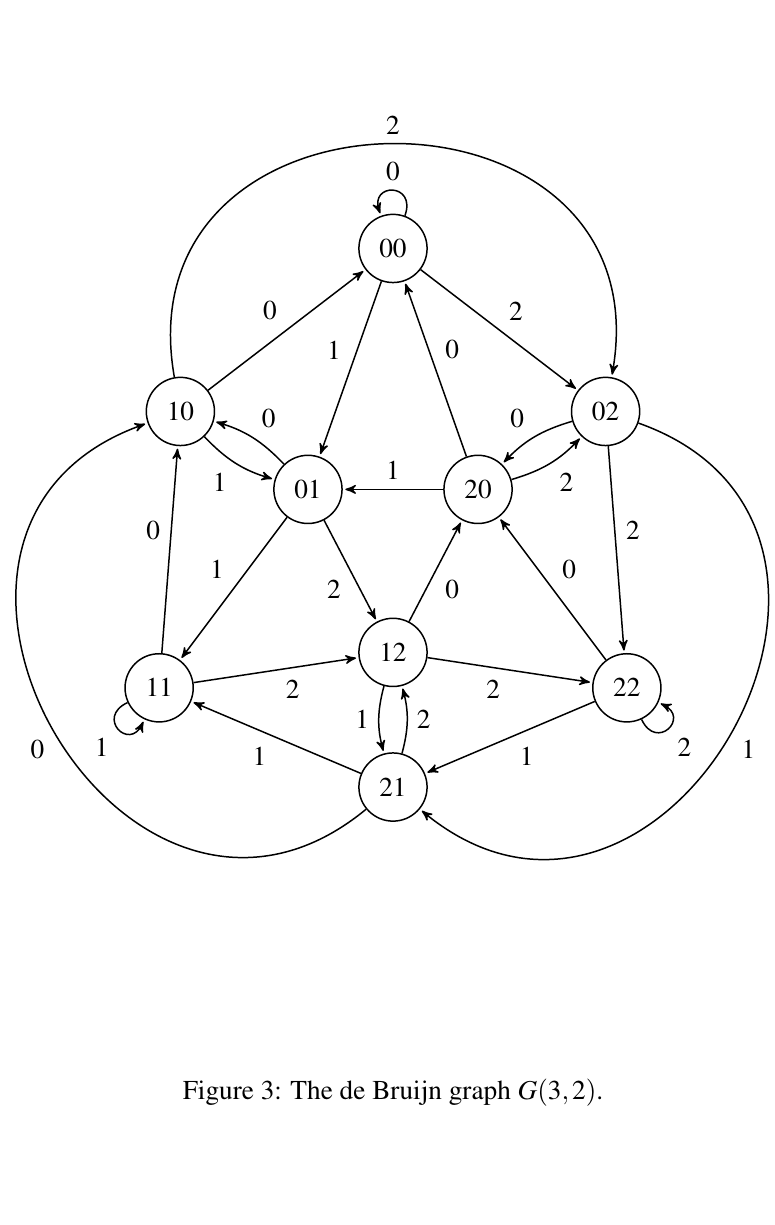
Figure 3: The de Bruijn graph G ( 3 , 2 )